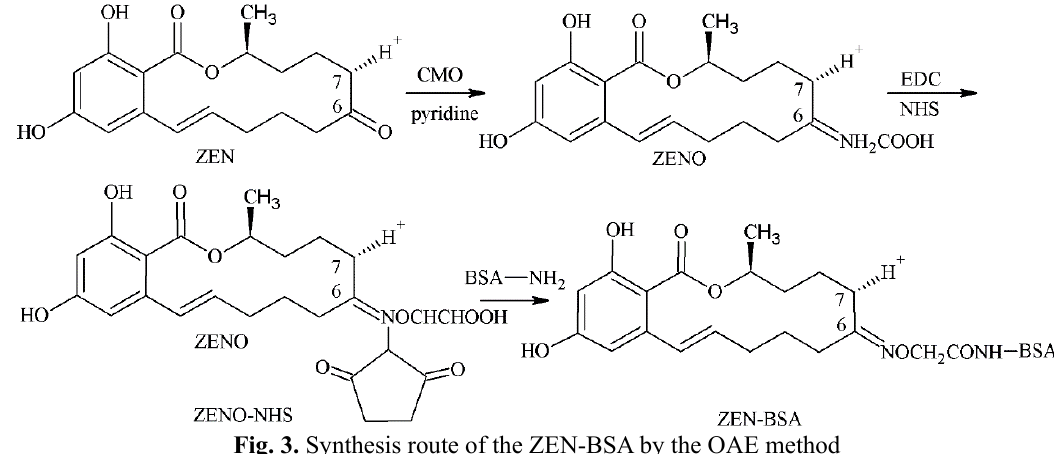
Fig. 3. Synthesis route of the ZEN-BSA by the OAE method